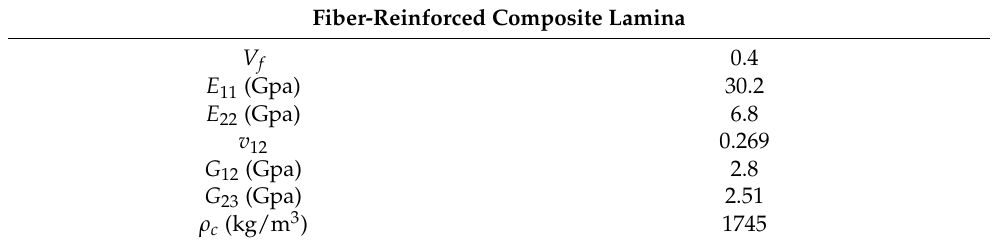
Table 1. Mechanical properties of the unidirectional fiber-reinforced composite